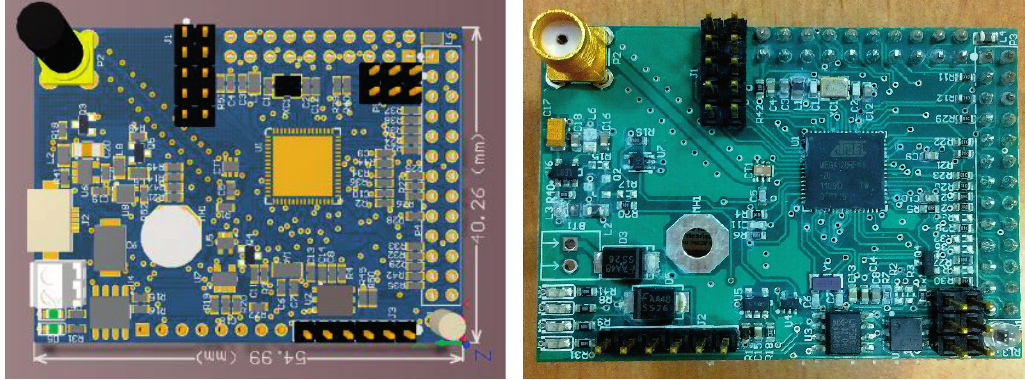
Figure 22. Prototype board of the multi-core node LiveWSN. Due to the ultra-low-power cost, tinyRisc is selected as the auxiliary microcontroller on the LiveWSN